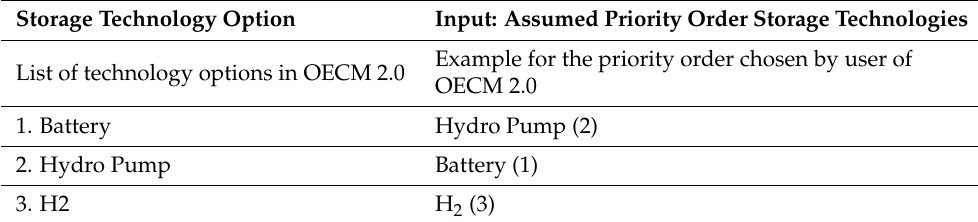
Table 12. Technology options—storage technologies. Storage Technology